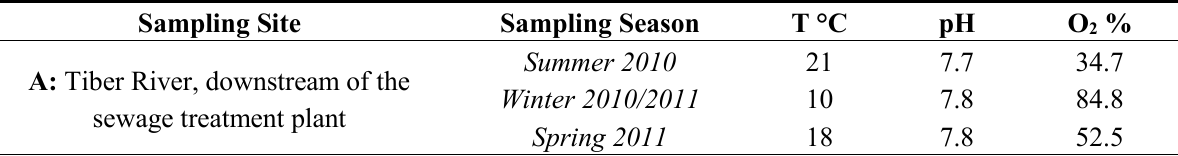
Table 2. Physical and chemical water parameters at the sampling